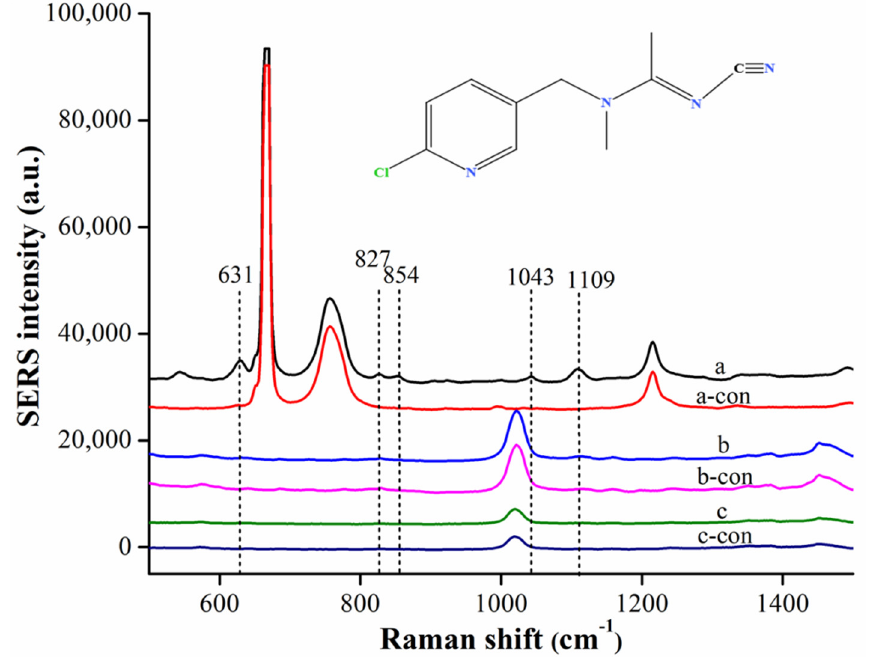
Figure 3. SERS spectra of acetamiprid at the concentration of 1.0 × 10 − 5 mol/L and corresponding controls collected by (a) self-assembled Au NP array based, (b) liquid based, and (c) dried liquid droplet based SERS analysis.